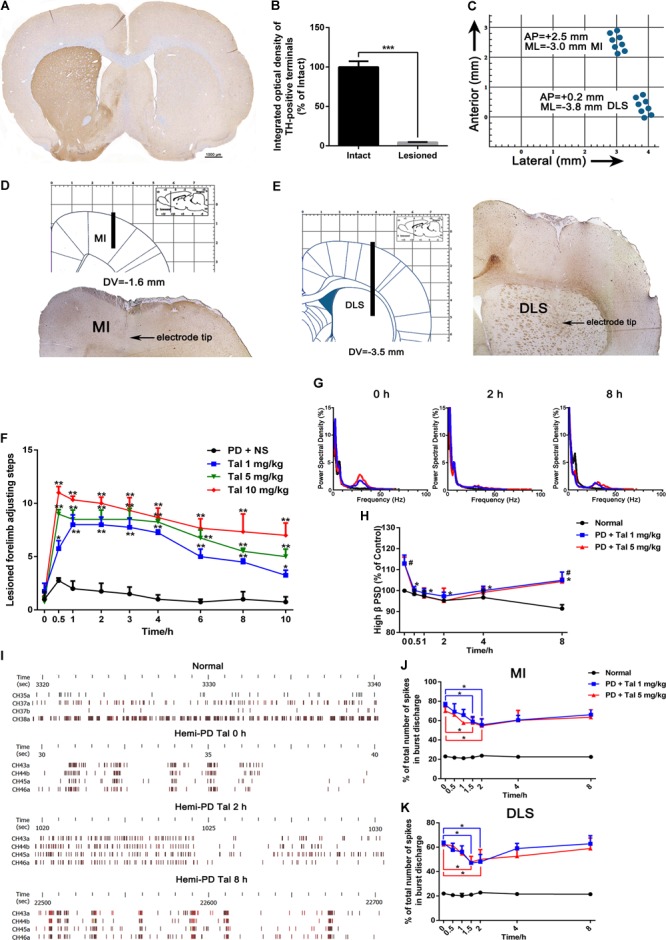
Taltirelin improved motor function and normalized aberrant electrical activity of 6-OHDA-lesioned rats. (A) Tyrosine hydroxylase (TH) immunostaining in the striatum of 6-OHDA lesioned rat model. (B) Integrated optical density of TH-positive terminals in the intact and lesioned side. N = 3. (C) Schematics illustrating horizontal positioning of recording electrodes targeting primary motor cortex (MI) or dorsolateral striatum (DLS) relative to bregma. (D,E) Coronal plane indicating schematic vertical positions for MI and DLS together with AP positions (left). Typical brain slice showed actual electrode position (right). Electrodes were implanted in the right (lesioned) side. (F) Adjusting step tests of PD rats treated with saline or Taltirelin (Tal 1, 5 or 10 mg/kg, i.p.). N = 6. (G) Typical example of power spectral distribution of local field potential (LFP) after treatment of Taltirelin (1 or 5 mg/kg, i.p.). (H) Power of high β oscillation changed with time (a total of 128 LFP data from two intact rats and six hemi-Parkinsonian rats). (I) Typical examples of raster plots showing the neuronal discharge patterns of normal or 6-OHDA-lesioned rats. (J,K) The % of total number of spikes in burst discharge of PNs or striatal projection neurons (SPNs) (a total of 75 PNs and 78 SPNs from two intact rats and eight hemi-parkinsonian rats). #p < 0.05 vs. control; ∗p < 0.05; ∗∗p < 0.01; ∗∗∗p < 0.001. Error bars denote SEM.